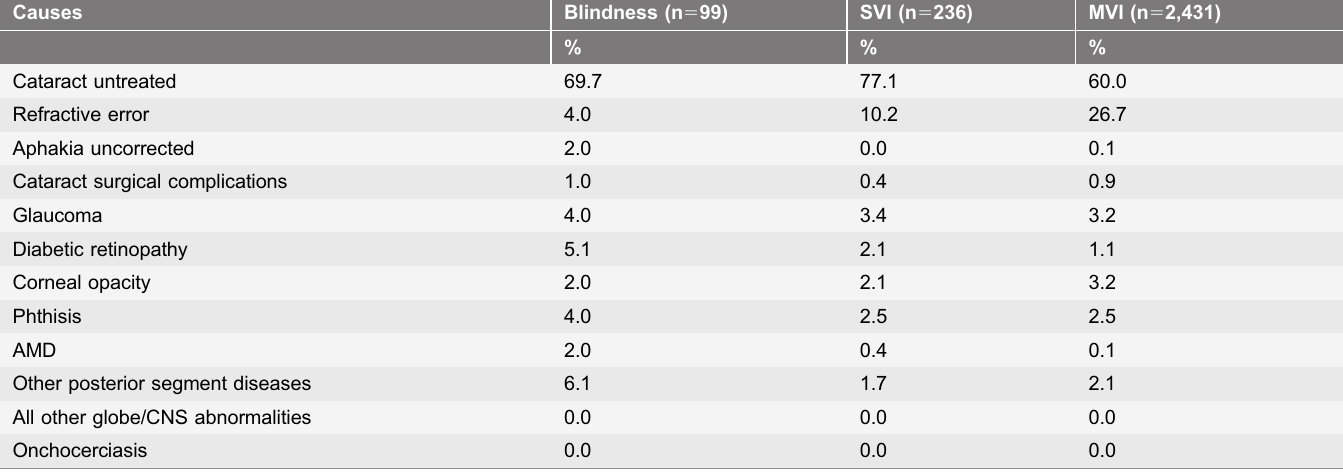
Table 5. Proportion of Blindness, SVI, and MVI in examined persons due to specific causes in Thailand.